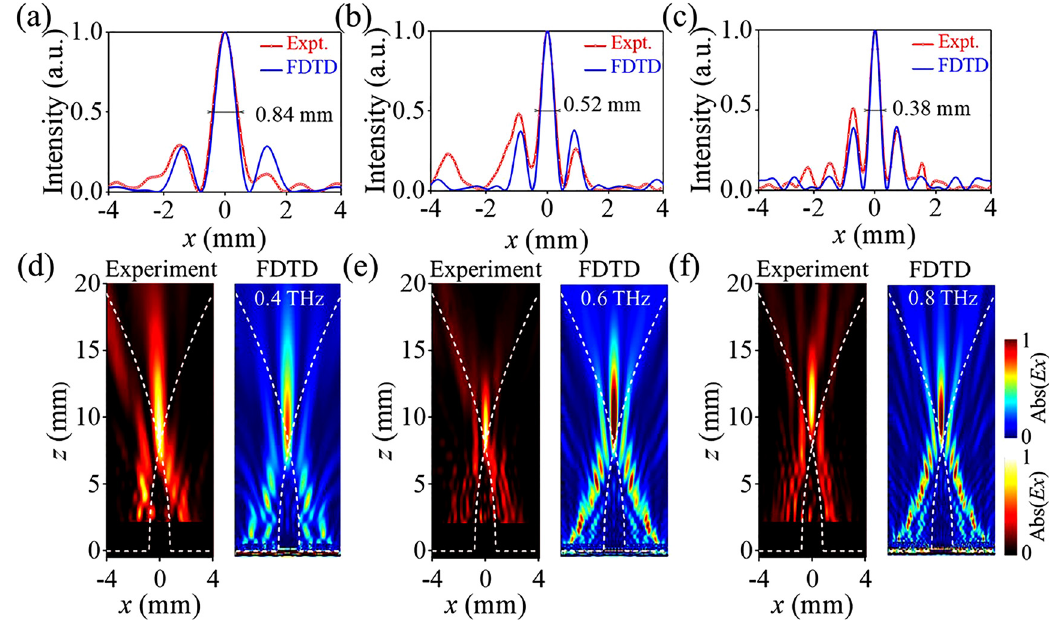
Figure 6: Achromatic Airy beam-based metalens. (a) – (c) Comparison of simulated and experimental results for the intensity distributions at the focal length. The full width at half maximum (FWHMs) of the intensity distribution are 0.84 mm at 0.4 THz, 0.52 mm at 0.6 THz, and 0.38 mm at 0.8 THz. (d) – (f) Demonstration of the generation of two counter-propagating achromatic Airy beams in experiments and simulations. The focal length f = 10